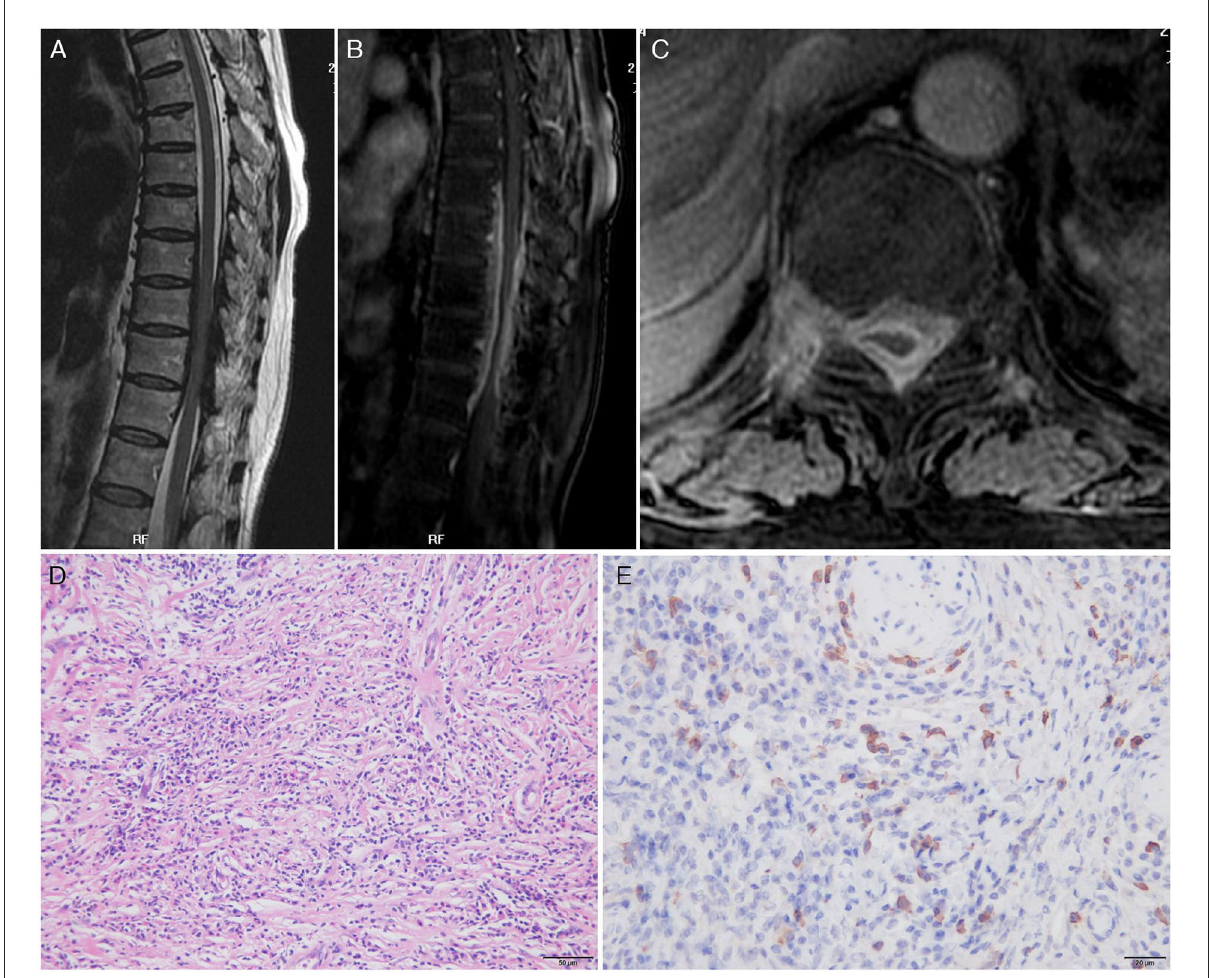
FIGURE3 Magnetic resonance imaging scan of the thoracic spine on admission and pathology findings. Sagittal T2-weighted image (A) showed a low-signal intensity lesion in the anterior and posterior epidural spaces and high enhancement after gadolinium enhancement (B) at the thoracic canal between T7 and T11 vertebral body levels. Axial images showed that the lesion was located in the epidural space and extended to the neural foramen to the right. A fat-suppressed T1-weighted image with gadolinium enhancement demonstrated high enhancement of the mass (C). Pathology findings: Hematoxylin and eosin stain of the epidural mass showed intense lymphoplasmacytic inflammatory cell infiltrate with fibrosis. Plasma cells and lymphocytes were also detected within the wall of a vessel as well as in the perivascular area (D) . IgG4 immunohistochemistry showed prominent IgG4 + cells within the inflammatory infiltration. Nearly more than half of the plasma cells exhibited IgG4 reactivity (E)